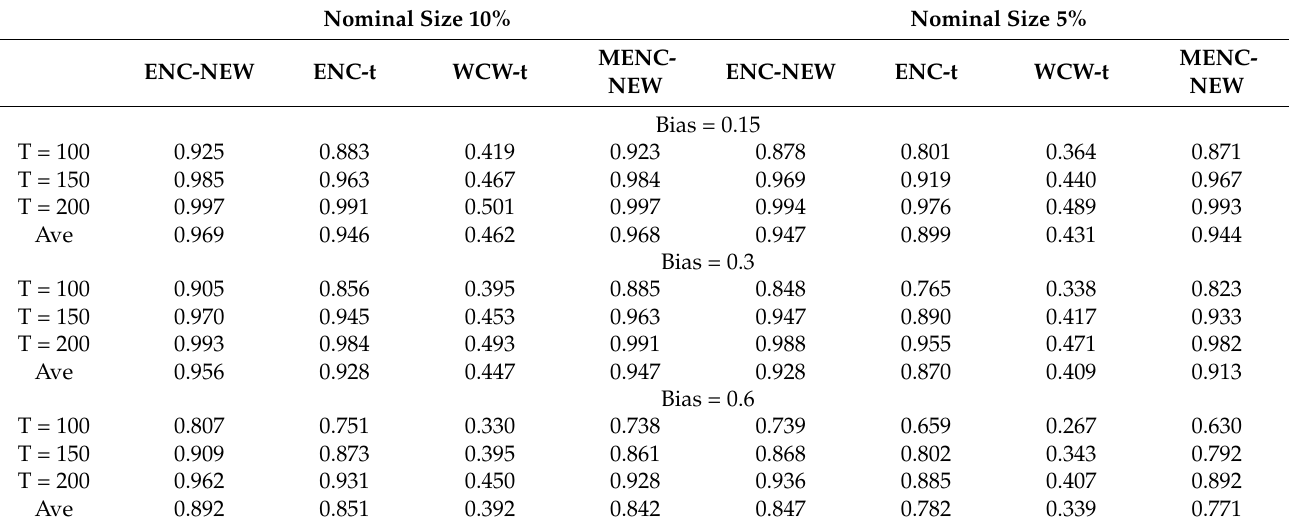
Table 8. Raw power with nominal sizes 10% and 5%, and P/R = 1.